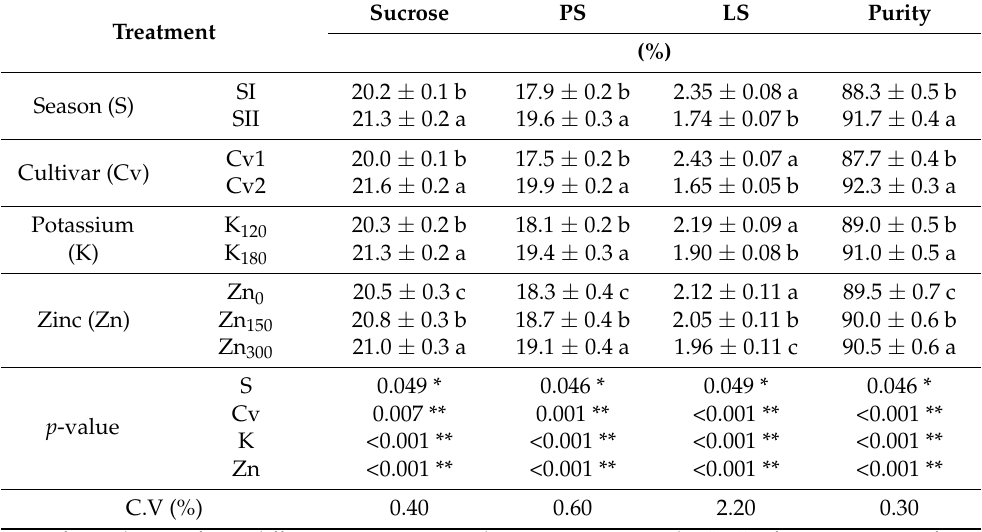
Table 4. Sucrose, pure sugar (PS), loss sugar (LS), and purity of two sugar beet cultivars (e.g., Kawemira (Cv1) and BTS 301 (Cv2)) affected by soil fertilization with two potassium levels (e.g., 120 (K 120 ) and 180 kg ha − 1 (K 180 )) and foliar application with three zinc levels (e.g., 0 (Zn 0 ), 150 (Zn 150 ), and 300 ppm (Zn 300 )) when grown under saline soil (EC e = 8.60 dS m − 1 ) conditions (data pooled over both